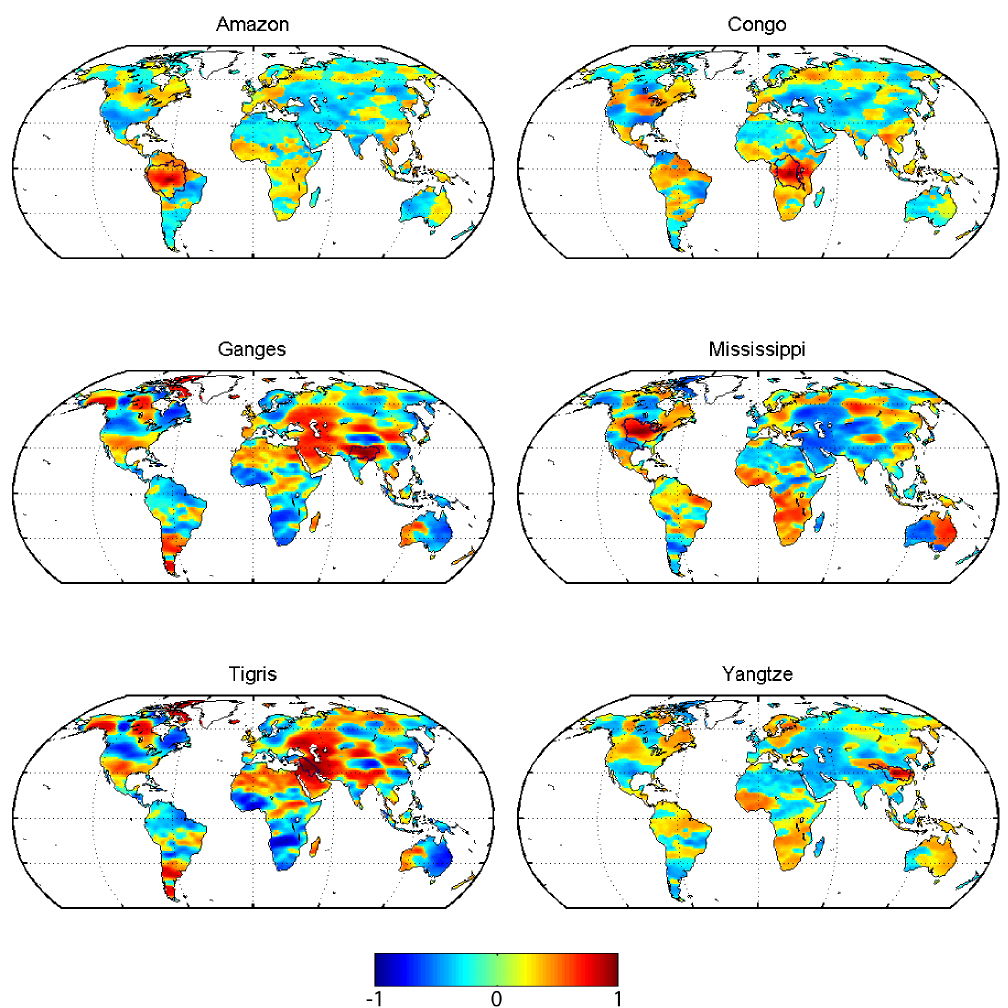
Figure B1. Degree centrality inferred from GRACE TWSA for six river basins, based on the maximum correlation between each basin centroid and all other cells in the grid, and within a window of [ − 18, 18]